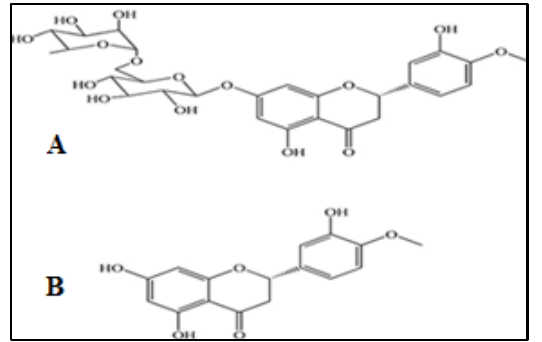
Figure 5. Chemical structure of quercetin (69) Luteolin